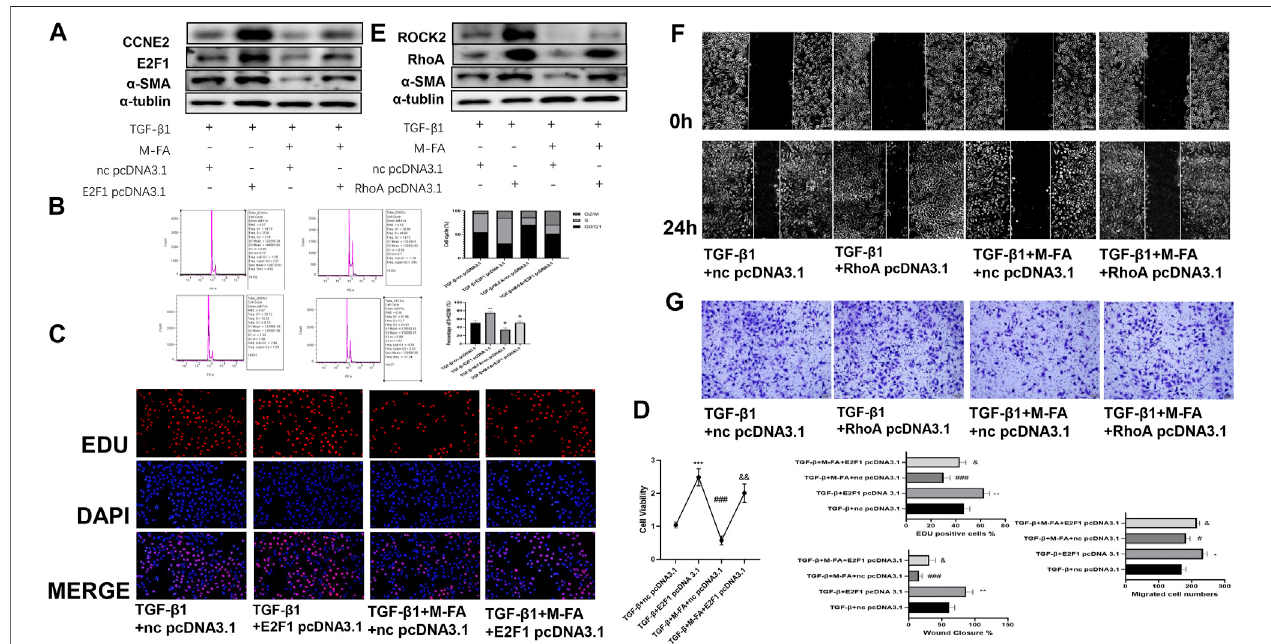
FIGURE 6 | MFA suppressed the expression of pRB, E2F1, CCNE2, RhoA, and ROCK2, regulated the cell cycle, and conjunction of RB and E2F1. (A – D) Rescue testforcellproliferationabilityandECMformationbyWesternblot(A)( n (cid:2) 3),cellcycleanalysis(B),EDUassay(C),andCCK-8assay(D)( n (cid:2) 6). (E – G) Rescuetestforcell migrationabilityandECMformationbyWesternblot(E)( n (cid:2) 3),Woundhealingassay(F),andTRANSWELLassay( n (cid:2) 6)(G).(*comparedwithnegativecontrol:* p < 0.05, ** p < 0.01, *** p < 0.005. # Compared with the TGF- β 1 group: # p < 0.05, ### p < 0.005. & Compared with the TGF- β 1 + MFA group: & p < 0.05, && p < 0.01).